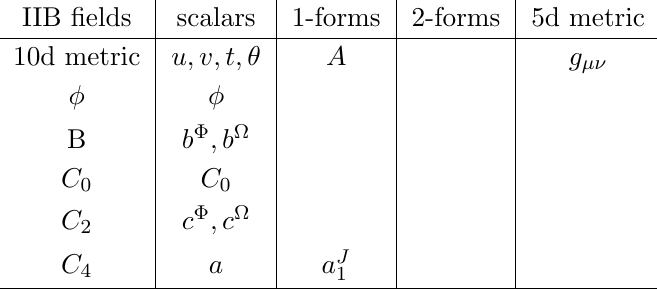
Table 2 . Field content for the N = 2, SU(2) (cid:2) SU(2) (cid:2) Z 2